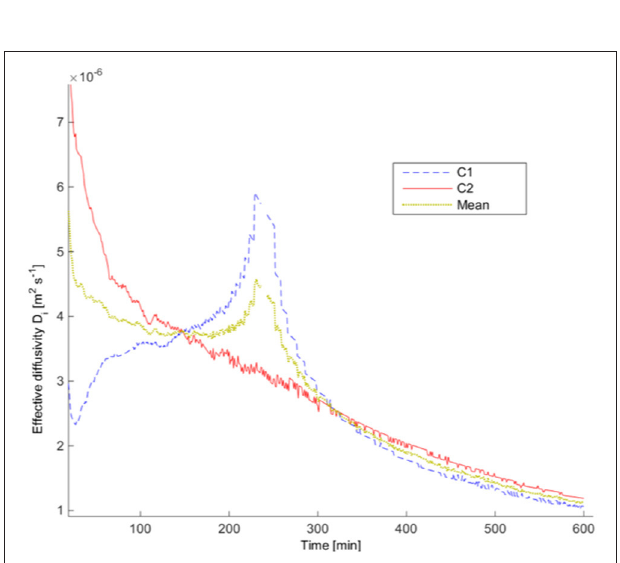
FIGURE 4 | Effective diffusivity values for 0.5 ′′ test 2, obtained using the inverse model given in Equation